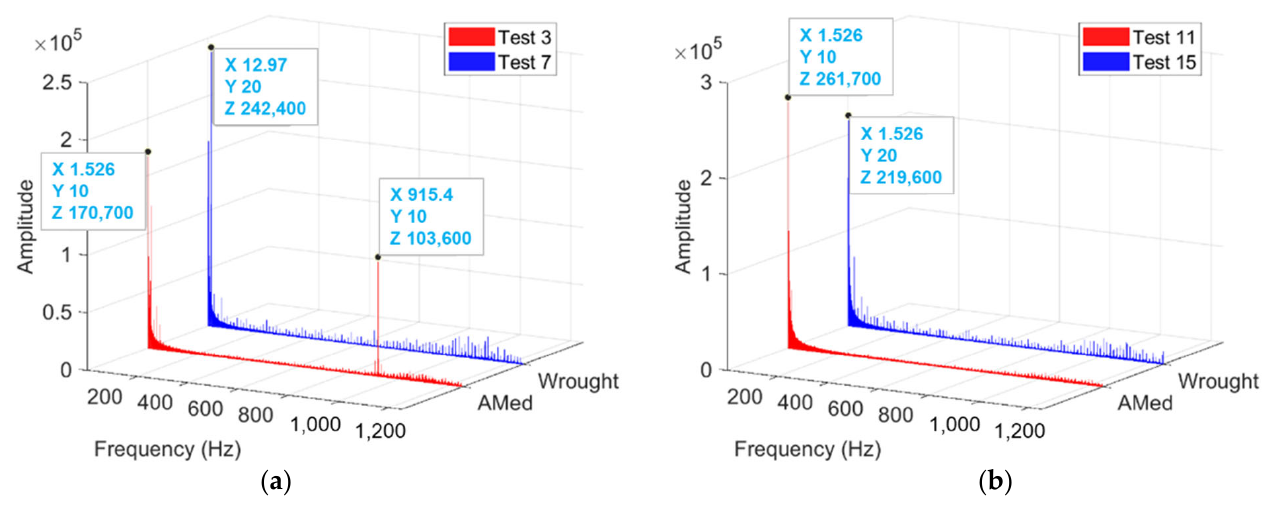
Figure 10. FFT of the signal of radial force when machining wrought and SLMed Ti6Al4V materials at the speed of 120 m/min and feed of 0.2 mm/rev: ( a ) at the cutting depth of 0.25 mm, ( b ) at the cutting depth of 0.5 mm.